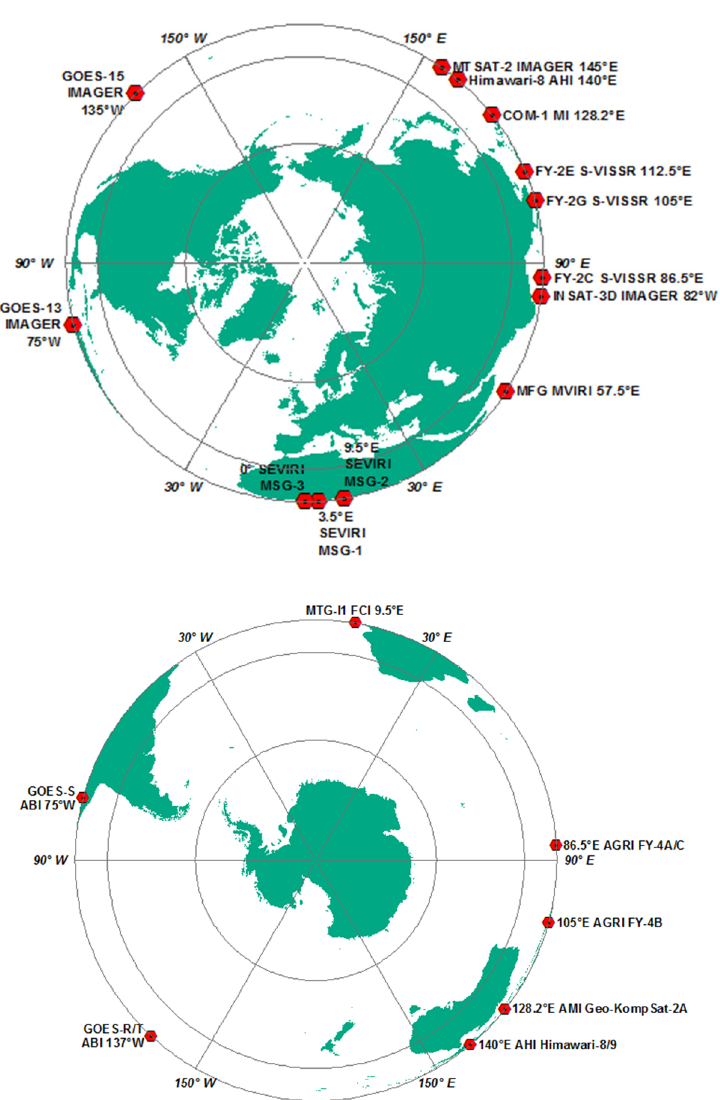
Figure 10. The Northern hemisphere image shows the currently operational geostationary satellites, and the Southern hemisphere the implementation of Earth Observation satellites planned by year 2020 [53]. 2020